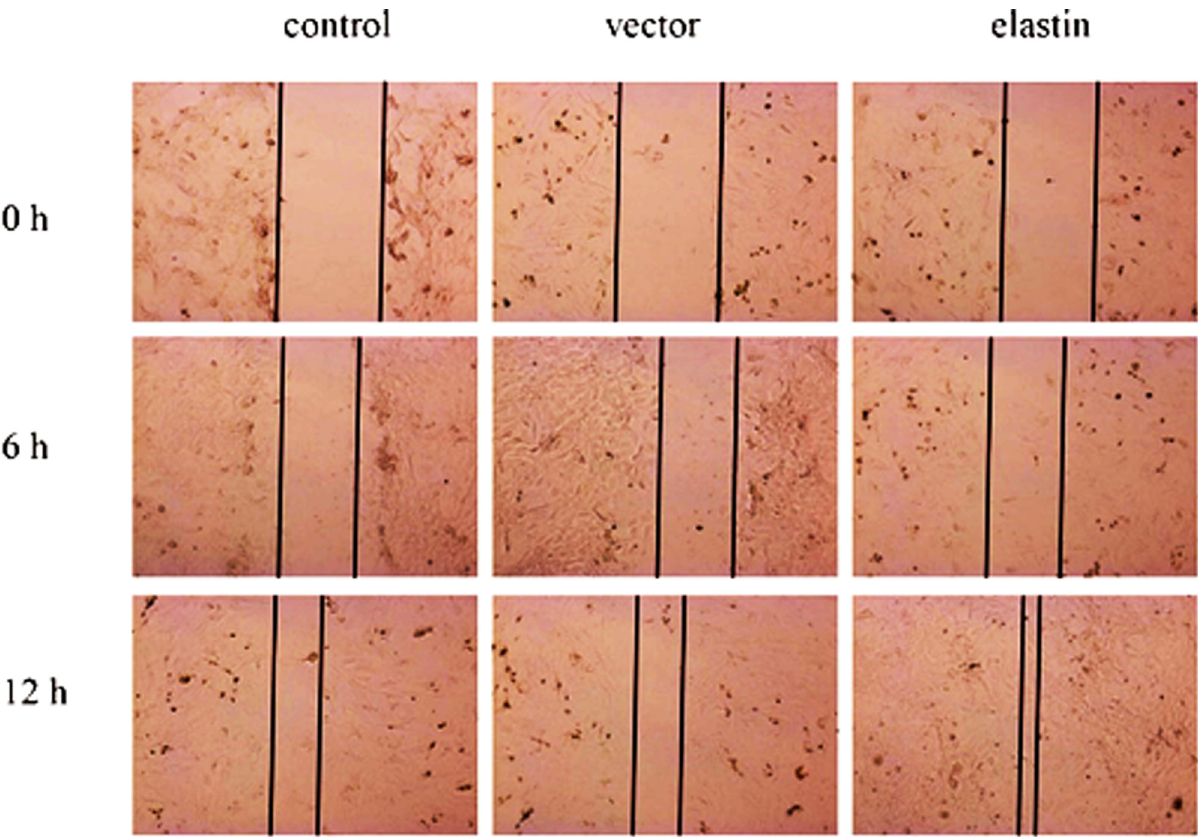
Figure 6: Optical images of BMSC migration with di ff erent treatments after incubating for various time periods (× 200 ) .